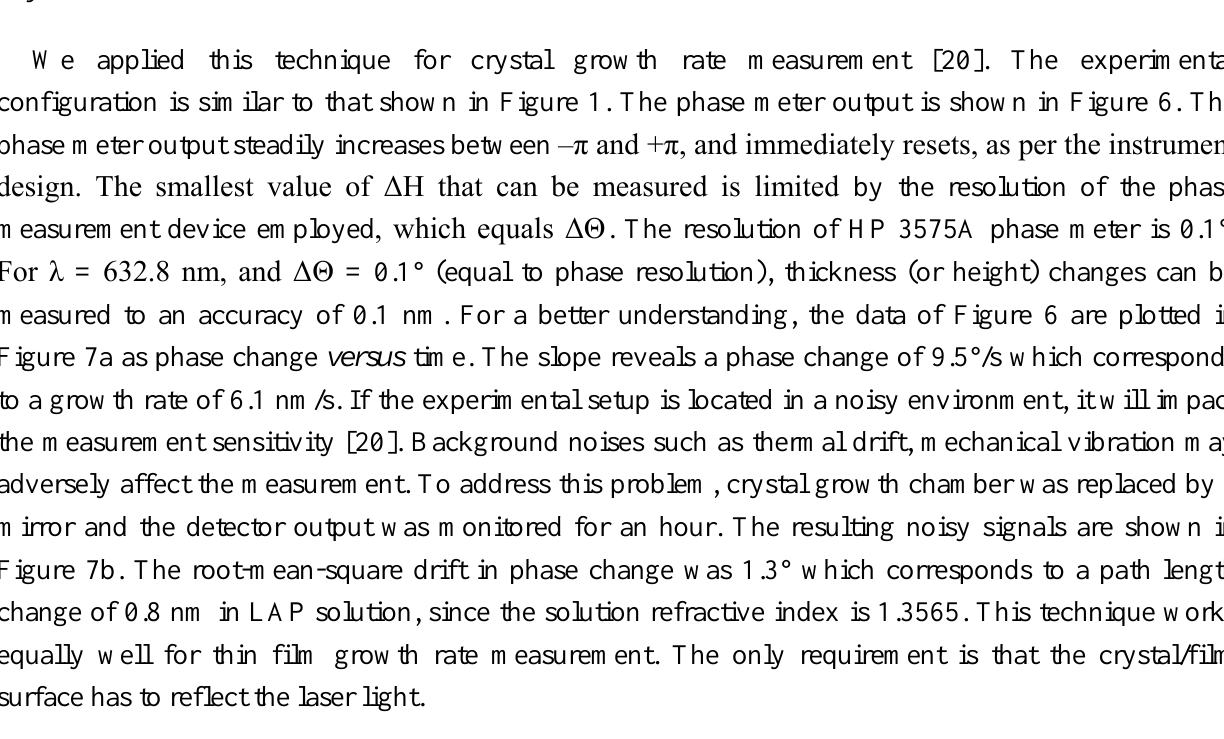
Figure 6. In situ measurement of crystal growth rate by the heterodyne detection technique